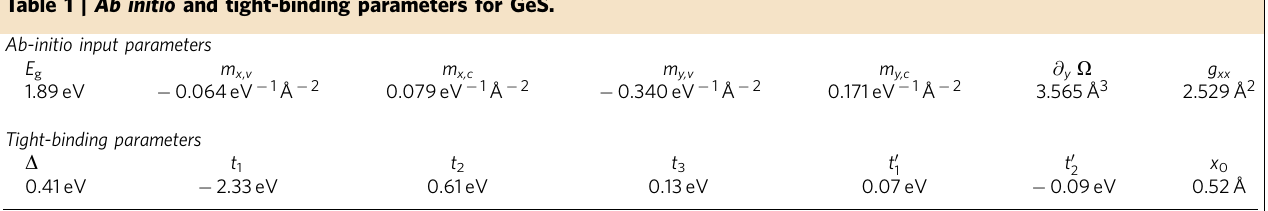
Table 1 | Ab initio and tight-binding parameters for GeS. Ab-initio input parameters E